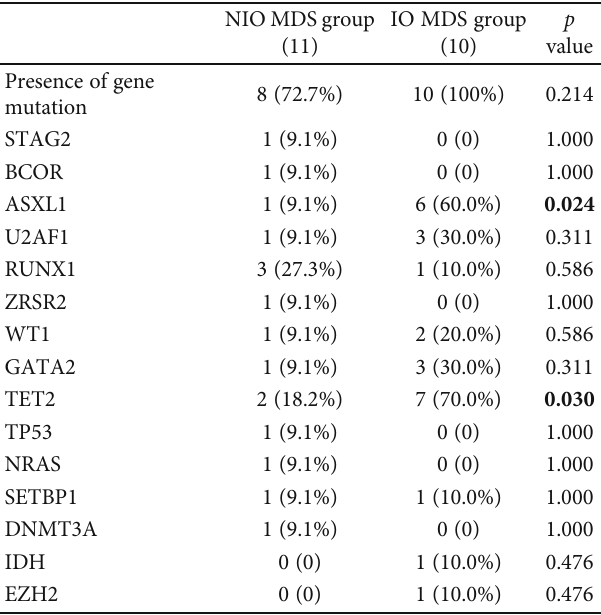
Table 2: Gene-speci fi c primers used in RT-PCR. Genes